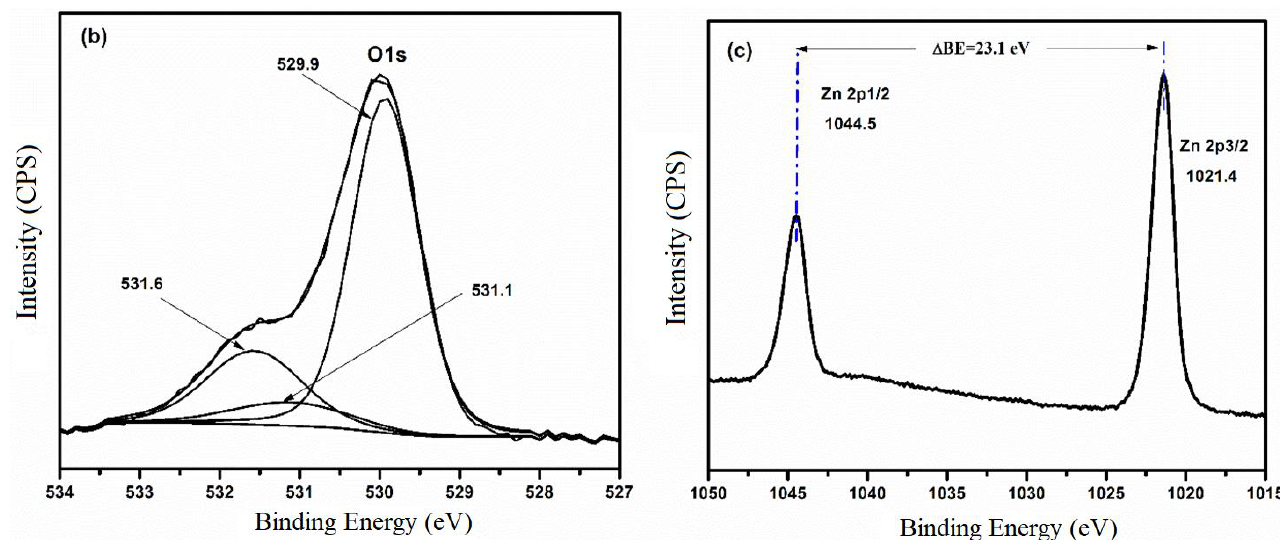
Figure 10. ( a ) Survey spectrum, ( b ) high resolution XPS spectrum of O 1s, and ( c ) Zn 2p of ZNRAs -